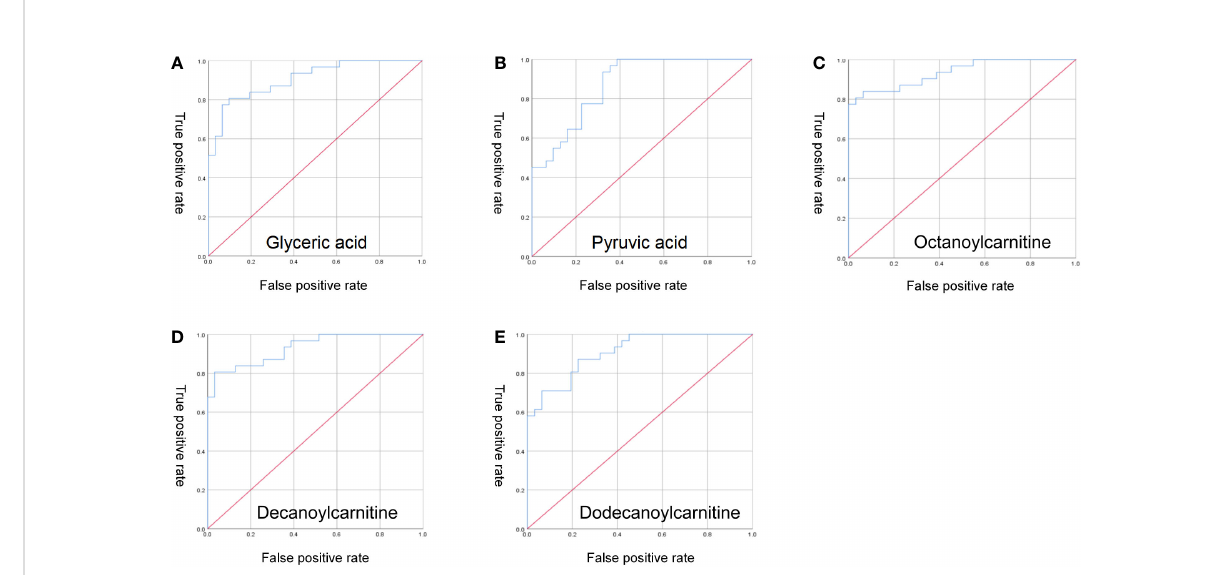
FIGURE 5 ROC curve analysis. (A) glyceric acid; (B) pyruvic acid; (C) octanoylcarnitine; (D) decanoylcarnitine; (E)